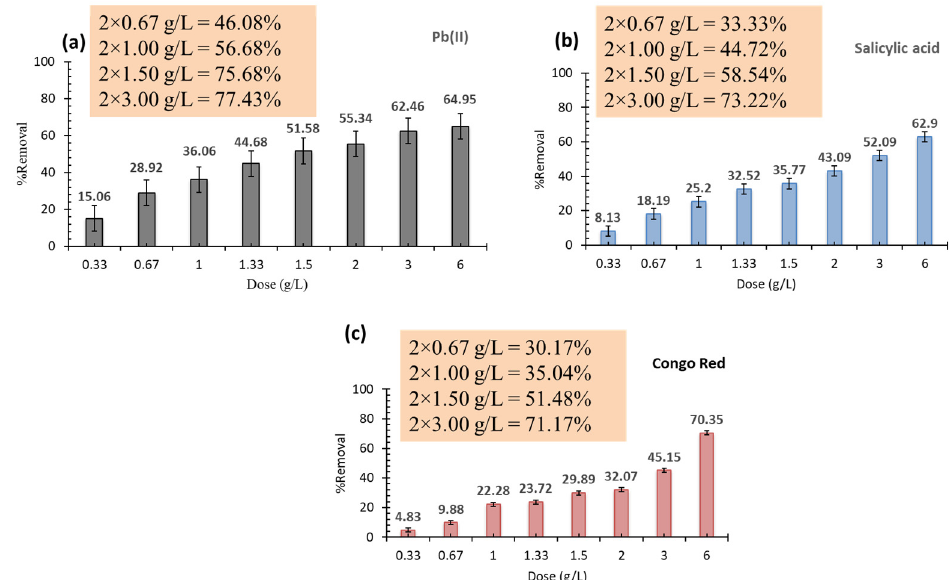
Figure 5. Bar graph of the dose effect of CsXM applied in one cycle of adsorption for ( a ) Pb(II), ( b ) SA, and ( c ) CR, while results for the 2 consecutive cycles of adsorption are embedded in the Figure insets. The initial concentration was 50 ppm, the contact time was 4 h, the temperature was 25 ± 2 °C, and pH values were 5.5 ± 0.1, 4.0 ± 0.3, and 6.1 ± 0.2, for Pb(II), SA, and CR, respectively. Error bars are expressed as mean value ± SD ( n = 3).